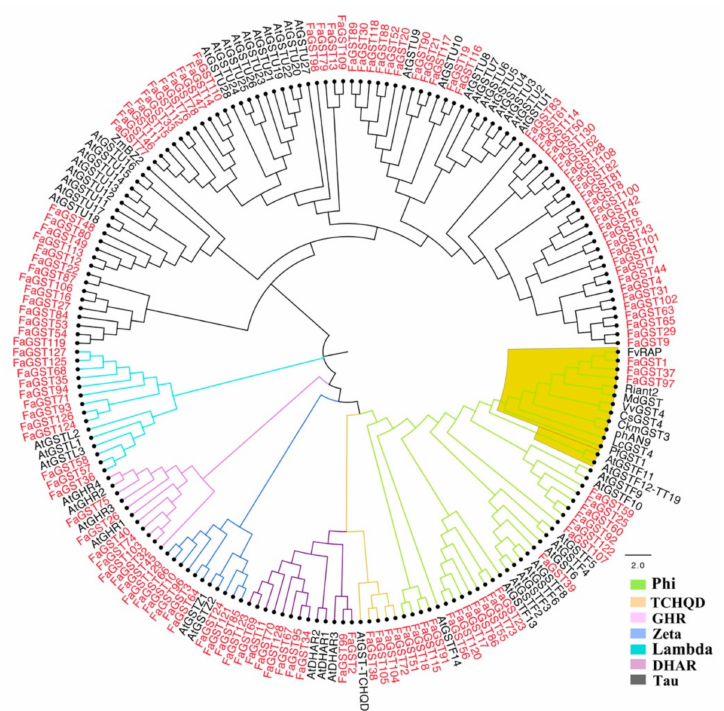
Figure 2. Phylogenetic tree constructed with 130 FaGST protein sequences with the GST from Arabidopsis. The tree was constructed using MEGA X with neighbor-join method. The red and black nodes indicated GST genes from strawberry and Arabidopsis. Di ff erent colored branches indicate di ff erent subclasses of GST genes, the highlighted branch indicates the anthocyanin-related GST genes as previously